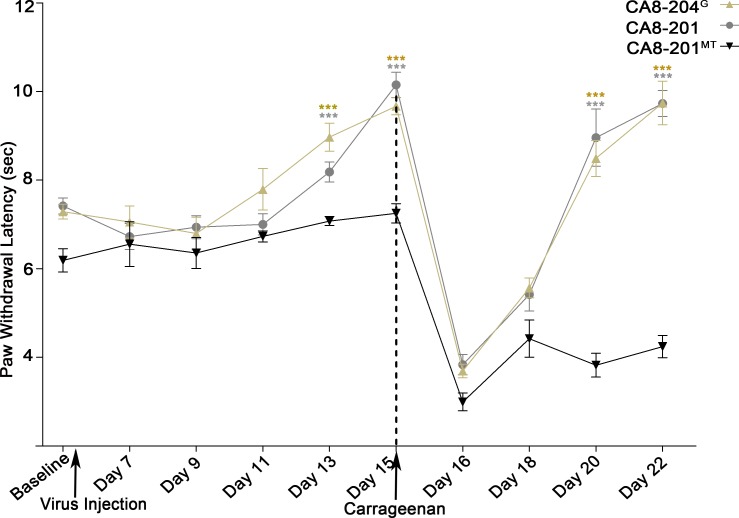
CA8-204G produces analgesic and anti-hyperalgesia similar to CA8-201 in carrageenan inflammatory pain models.Gene transfer of AAV8-FLAG-CA8-204G (CA8-204G); AAV8-V5-CA8-201WT (CA8-201WT); AAV8-V5-CA8-201MT (CA8-201MT); or empty vector were injected via the sciatic nerve injections before carrageenan injection to produce an inflammatory pain model. Paw withdrawal thermal latencies were measured daily after baseline, after virus injection and/o and after carrageenan injection (left paw). Mice that received AAV8-FLAG-CA8-204G (1.5μl, 1E13 genome copies/ml) after day 7 had a significantly higher threshold for pain compared to CA8-201MT, especially on days 13 and 15. Increasing paw withdrawal latencies reached a maximum of 10–12 seconds on day 14–15, similar to CA8-201WT. CA8-201MT produced no similar increase in withdrawal latencies. After carrageenan injections on Day 15, all groups showed reduced paw withdrawal latencies through day 18. However, mice in the CA8-201WT and CA8-204G groups showed a significantly enhanced paw withdrawal latency on days 20 and 22 compared to the CA8-201MT, indicating the anti-hyperalgesia protection was provided by the CA8-204G. On days 13, 15, 20, and 22 mark the differences in paw withdrawal latency significantly greater than baseline, in CA8-201 and CA8-204G compared with CA8-201MT. Mice in the negative control group showed paw withdrawal latency either at baseline or below baseline on these days. N = 8, ***P<0.001, **P<0.001 Two-way (repeated measures ANOVA) followed by Bonferroni’s post-hoc test statistical group test (GraphPad Prism).